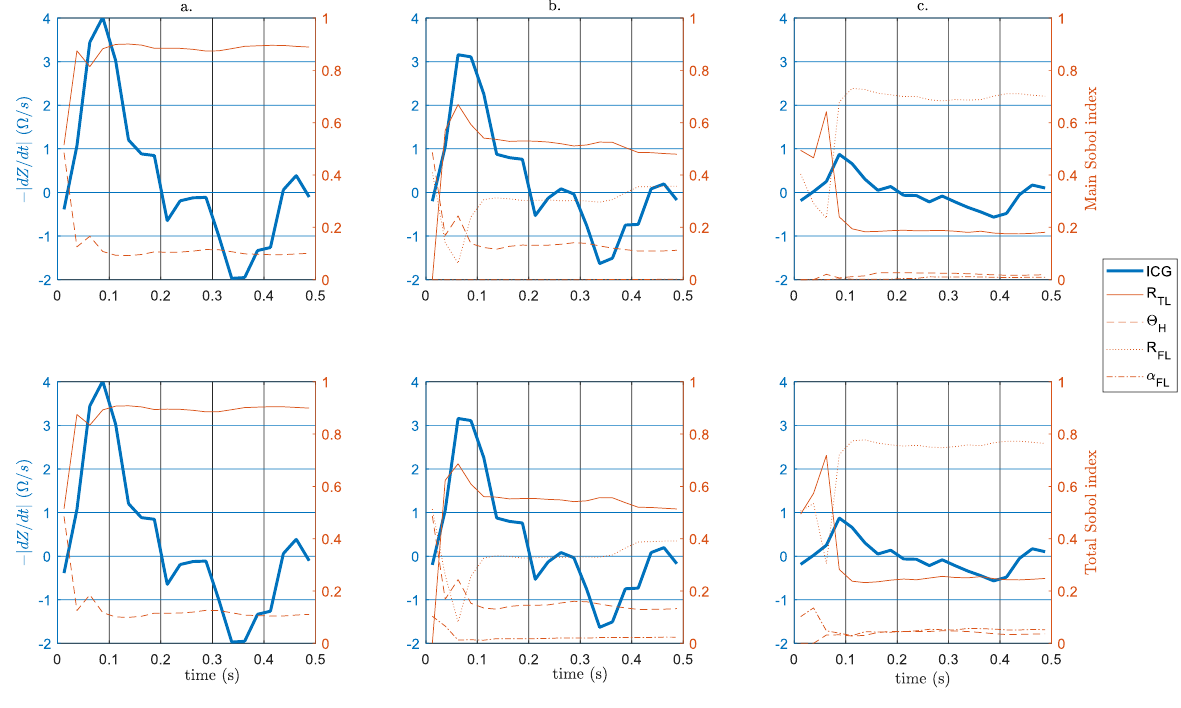
Fig.12: Sensitivity analysis on a. 𝐻𝐶̂ 𝐶,4𝑃𝐶𝐸 (𝑡) , b. 𝐷𝐶̂ 𝐶,4𝑃𝐶𝐸 (𝑡) , c. 𝑌̂ 𝐶,4𝑃𝐶𝐸 (𝑡)